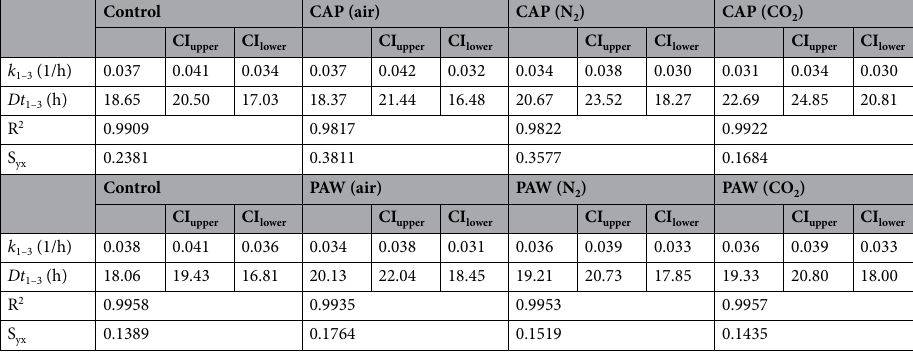
Table 1. Growth rate ( k ) and doubling time ( Dt ) of mung bean sprouts grown from CAP treated seeds and PAW irrigated seeds.